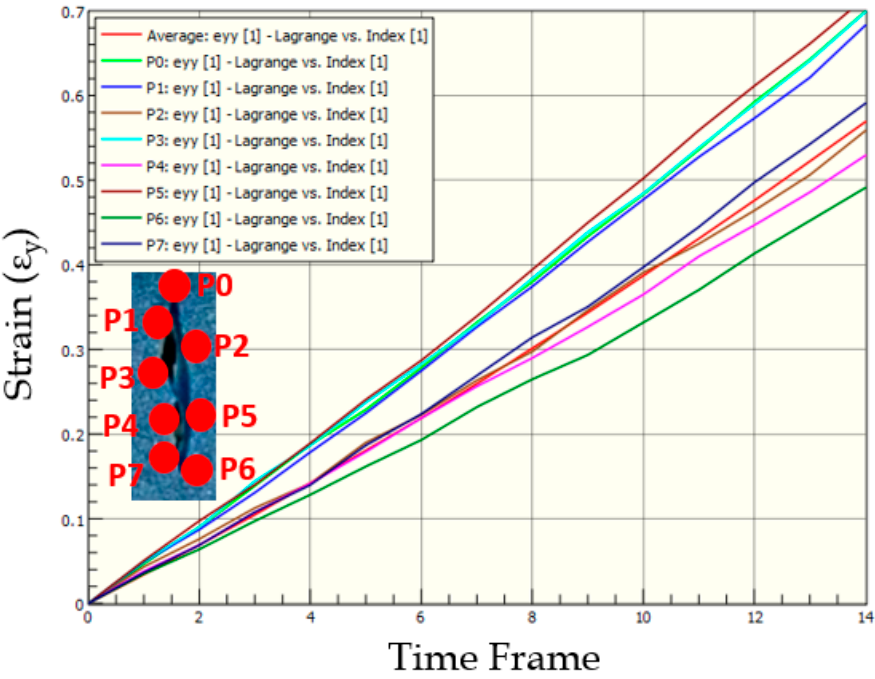
Figure 15. Average strain (y ‐ axis) versus time frame (x ‐ axis) measured using DIC from tensile test on the skin phantom specimen 4 with wound.